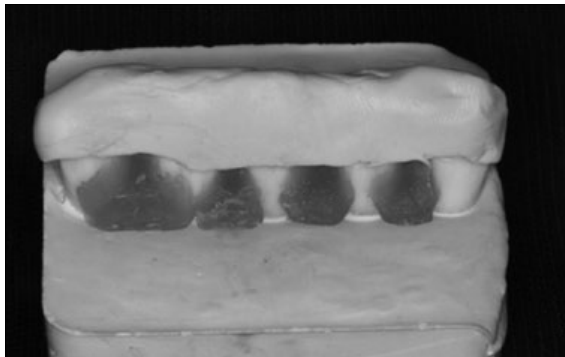
Figure 4. Transfer tray positioned on the